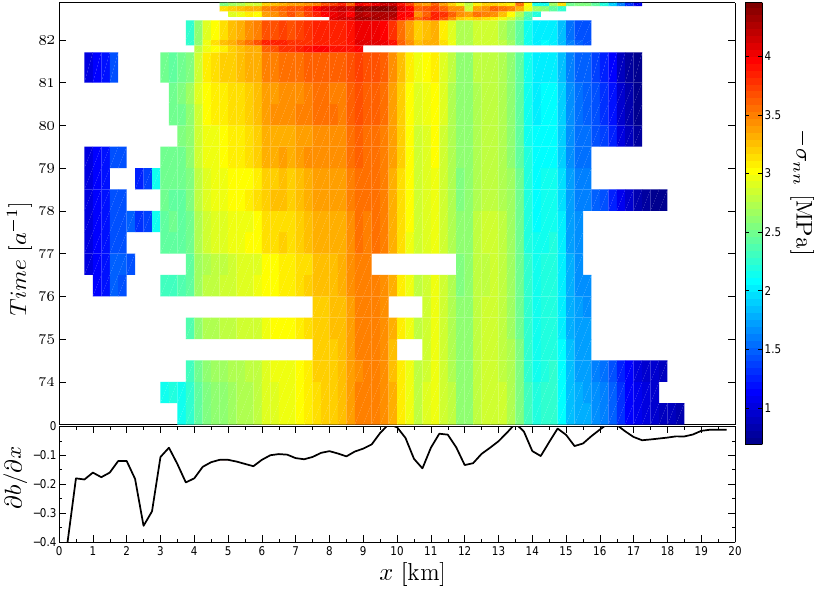
Fig. 7. Evolution with time since 1973 (vertical axis) and position along the central flow line (horizontal axis) of the modelled basal normal stress − σ nn [MPa]. The lower panel represents the bedrock slope ∂b/∂x .